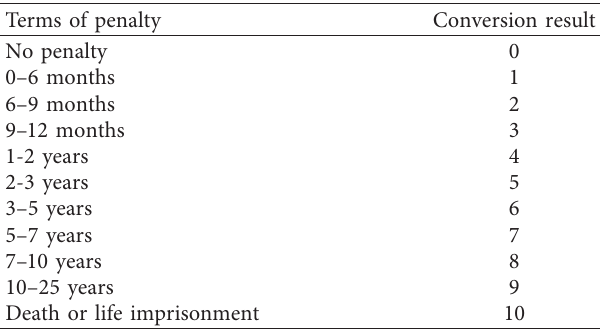
Table 5: Terms of penalty conversion